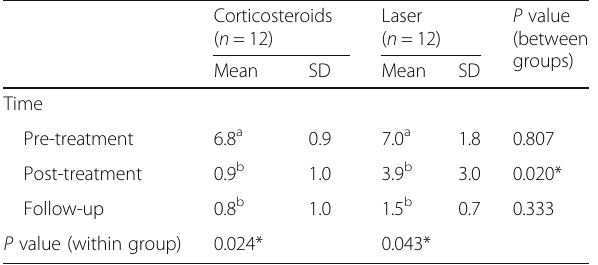
Table 3 Mean, standard deviation (SD) values, and results of comparison between RAE scores in the two groups as well as the changes within each group